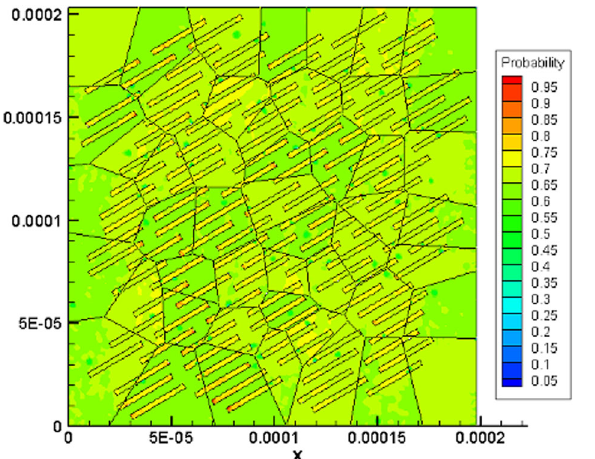
Fig. 16 A sample microstructure showing visual cracking probabil- ities as a heat map generated by the trained models, showing how cracks are most likely to initiate near hydride tips.